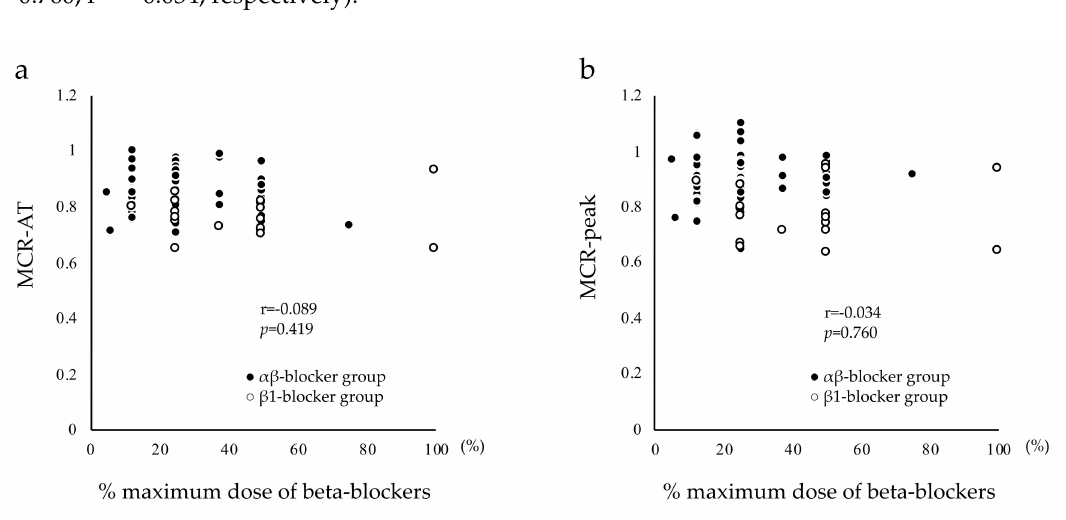
Figure 1. Correlations between MCR-AT, MCR-peak, and % maximum dose of beta blockers. Figure 1a shows correlation results between MCR-AT and % maximum beta-blocker dose. In patients undergoing beta-blocker dose. Figure 1b shows correlation results between MCR-peak and % maximum beta-blocker dose. In patients undergoing beta-blocker treatment, no significant correlations were observed